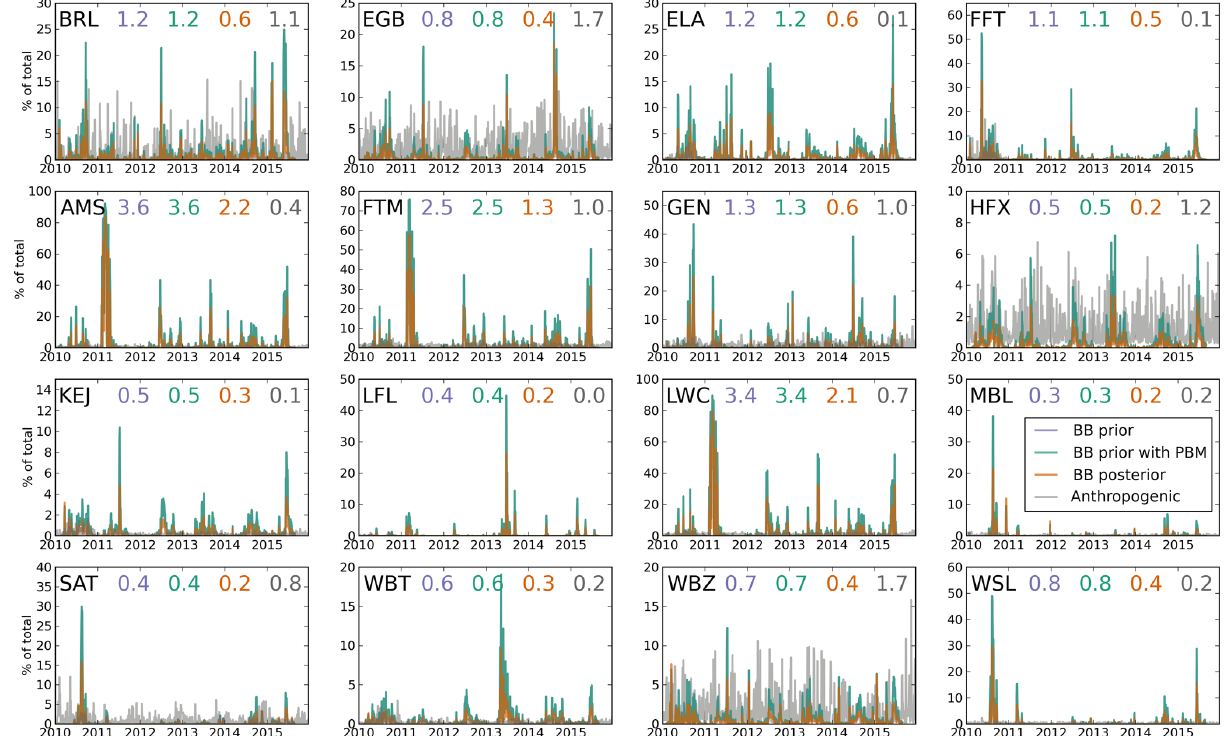
Figure 11. Same as Fig. 9, but for the Canadian observation